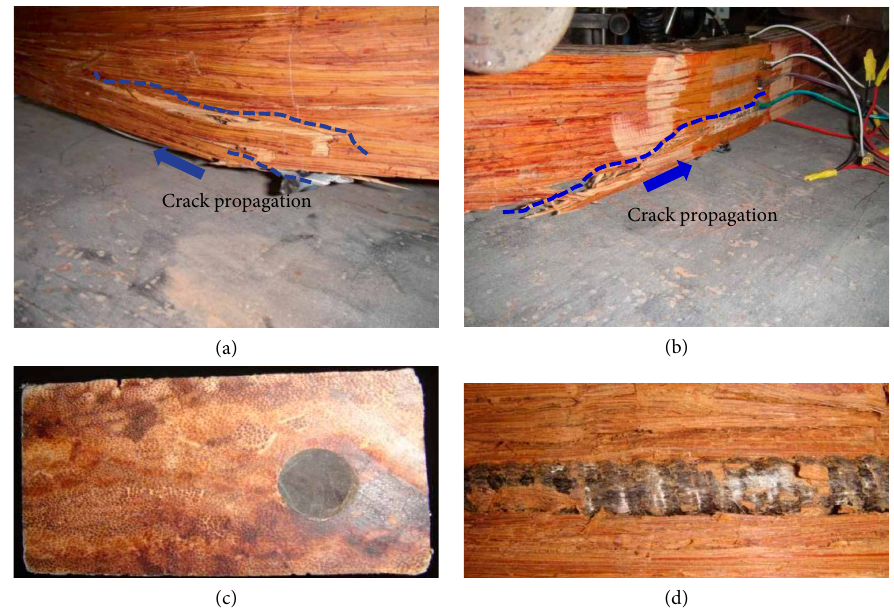
Figure 7: Failure photos: (a) failure position of specimen A0, (b) failure position of specimen A1, (c) end of specimen A1, and (d) the BFRP bar in the middle of the laminated bamboo